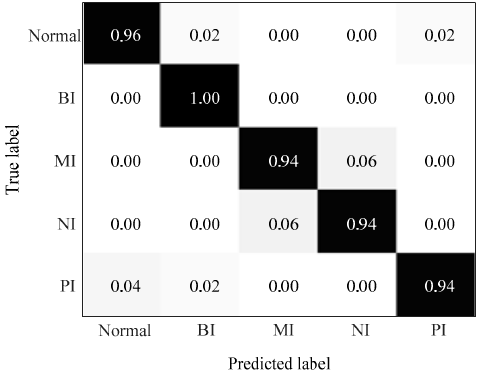
Figure 16. Confusion matrix using the proposed HLZC method for Experiment 2.